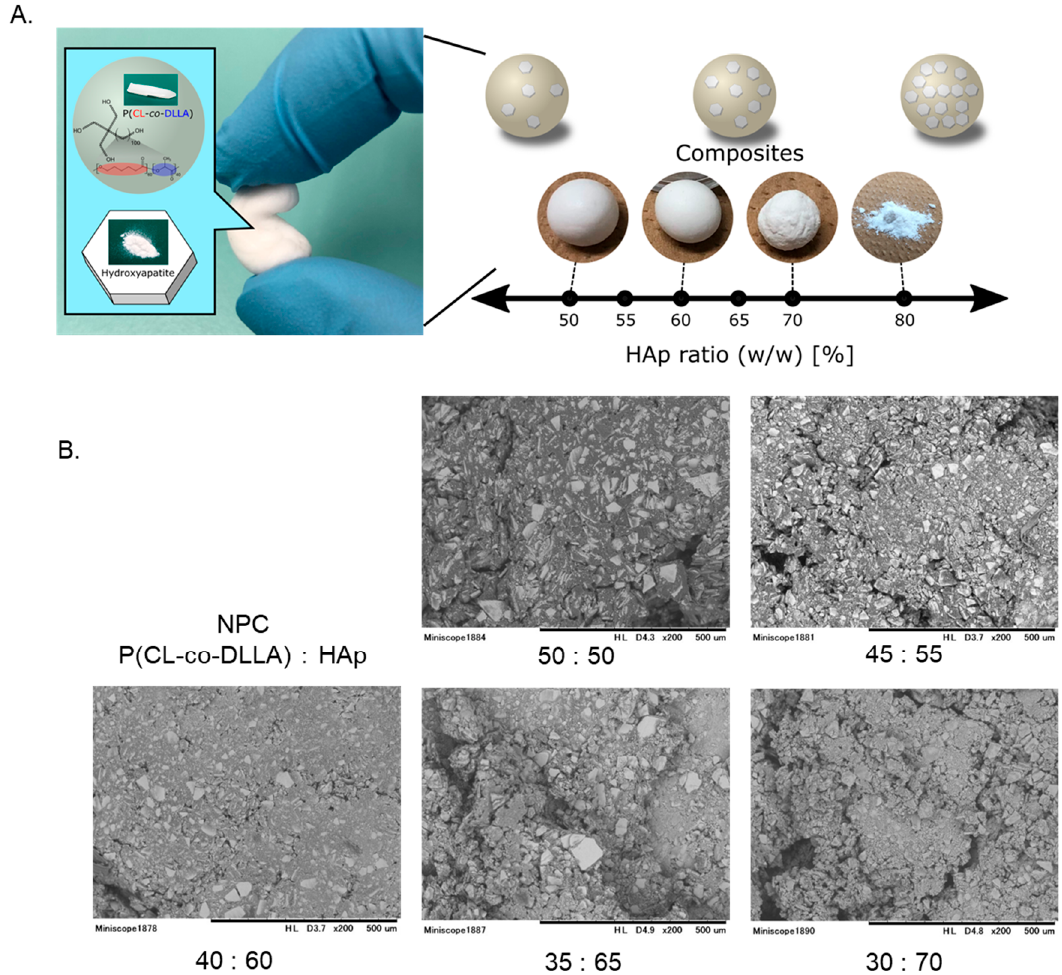
Figure 1. Fabrication of novel polymer carrier for pulp capping. Representative image of each HAp ratio ( A ). HAp ratios of 50% to 60% were good for application handling. Representative SEM images (200 × ) are shown ( B ). An HAp ratio higher than 65% could not be maintained. HAp = hydroxyapatite, NPC = novel polymer carrier for pulp capping, CL = ε -caprolactone, DLLA = d , l -lactide.